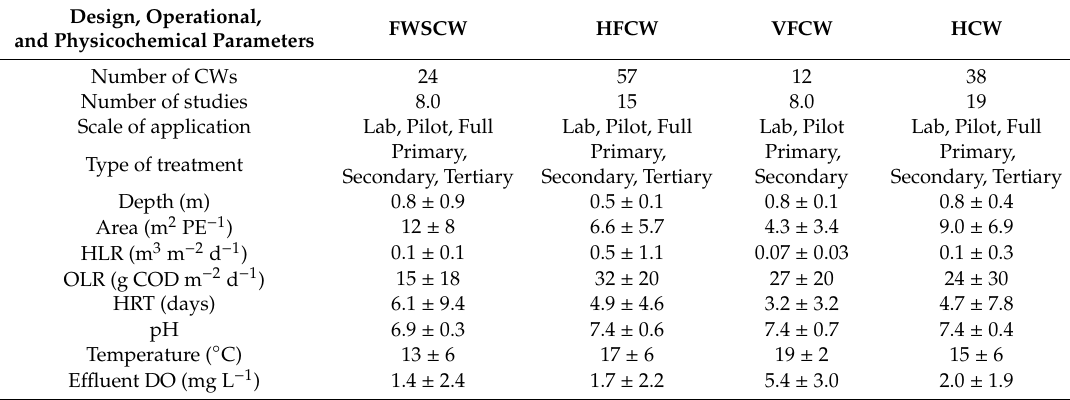
Table 3. Summary of selected design, operational, and physicochemical parameters of the studied four types of